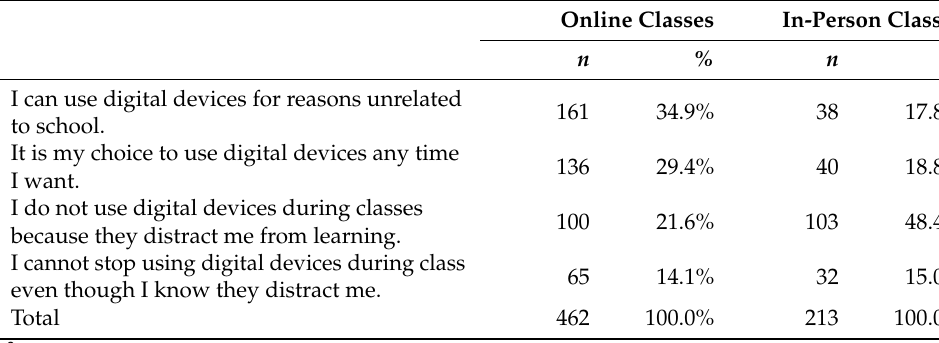
Table 9. Which of the following statements best describes your use of digital devices for other than course-related activities?